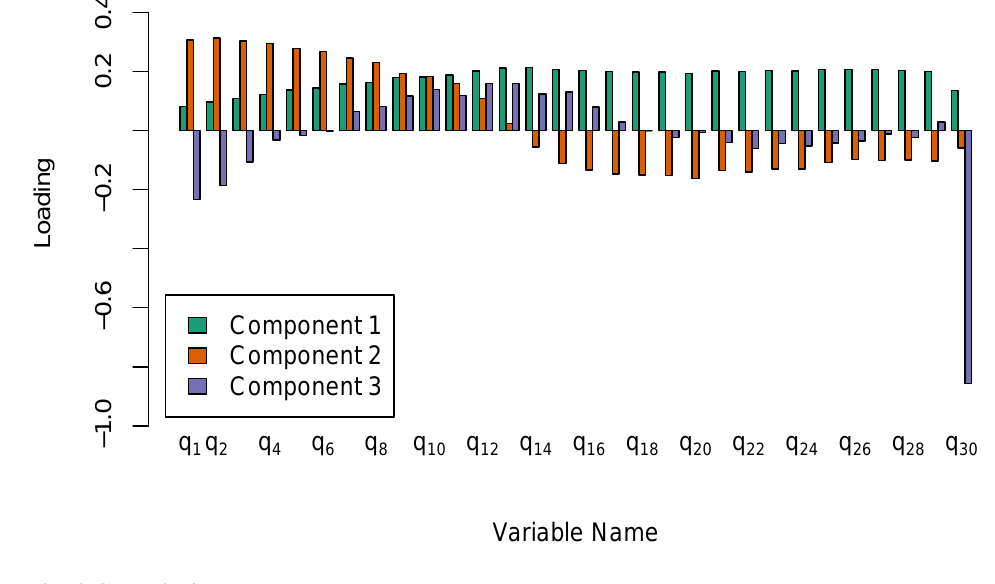
Figure 7. Loadings of the first three principal components of the Fourier interquartile range variables ( q to q 1 30